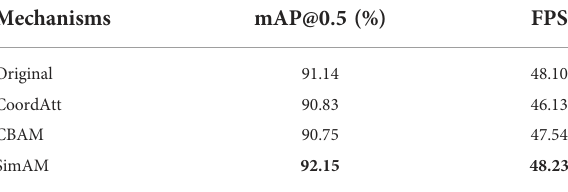
TABLE 3 Model training results when various attention mechanisms were used.